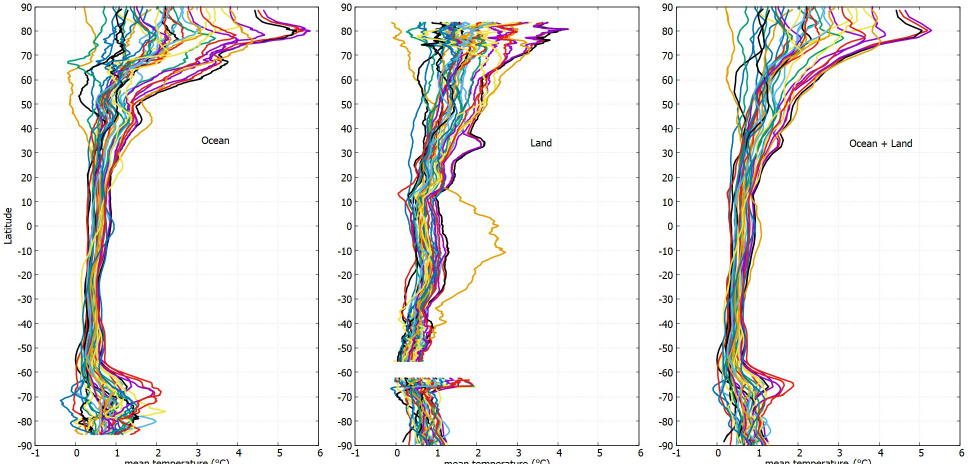
Figure 6. Latitudinal warming profile from 1980–1990 to 2011–2021 produced by 38 CMIP6 models. Figure 7 compares the latitudinal warming profile from 1980–1990 to 2011–2021 pro- duced by three adopted temperature records (ERA5-T2m, ERA5-850mb, and the UAH MSU v6.0 Tlt) (red curves) against the CMIP6 models: their average profile (black curves) plus/minus one standard deviation ( ± 1 σ ) (blue curves). The land, the ocean, and the land+ocean areas are shown in different panels. Each panel also reports the correspondent mean Student t -test value calculated by averaging the weighted values for each latitude: √ t = ( ¯ x − µ ) / ( σ / n ) , where ¯ x and σ are the sample mean and standard deviation among the n models and µ represents the data. There are n = 38 independent models and the degree of freedom is n − 1 = 37. The hypothesis that the CMIP6 model ensemble recon- structs the temperature profile can be rejected at the significance level 0.05 when t ≥ 2.03; this happens in all cases but for the ERA5-T2m land